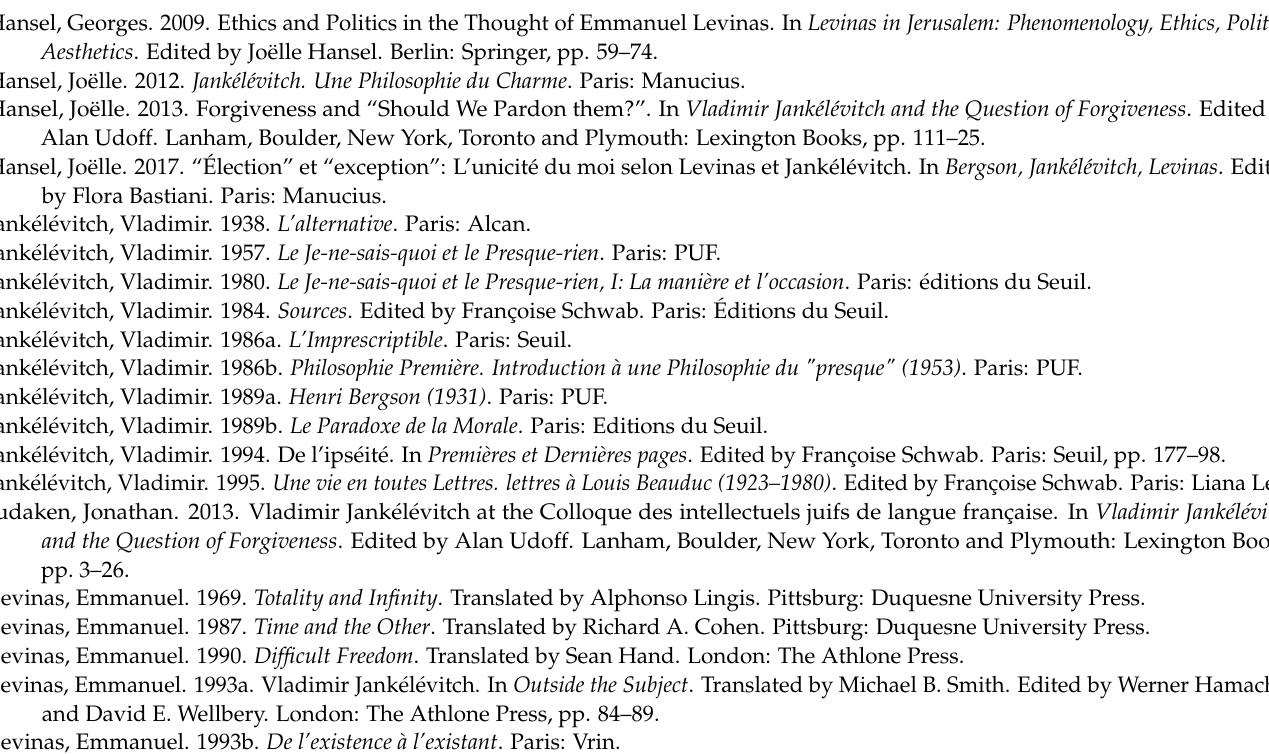
Jank é l é vitch insisted on the capital distinction between racism and anti-Semitism in a letter dated November 1980, right after the anti-Semitic terrorist attack at the Copernic Street synagogue in Paris, addressed to a group of students I belonged to, “so as to keep at bay any attempt of “banalization” of the